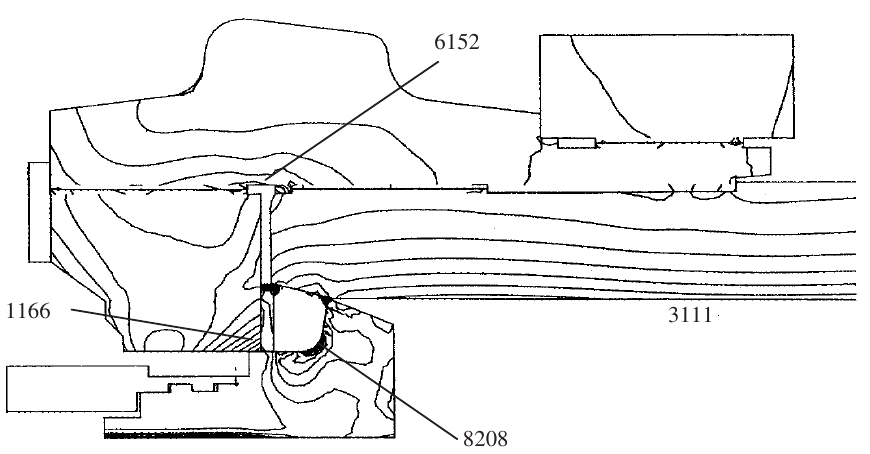
Fig. 4. Typical mises stress contour at a pressure of 310